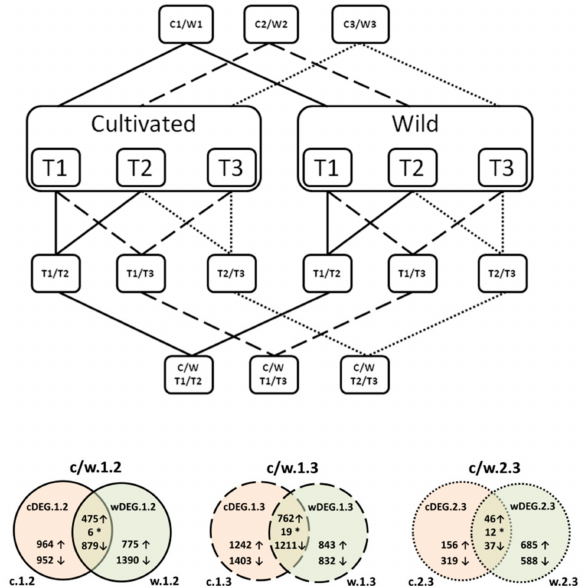
Figure 1. A diagram illustrating the applied experimental strategy and Venn diagrams showing numbers of differentially expressed genes (DEGs) identified in comparisons between wild (w) and cultivated (c) carrots in each of the three timepoints. ↑ —upregulated genes; ↓ —downregulated genes; *—genes with discordant expression patterns between wild and cultivated